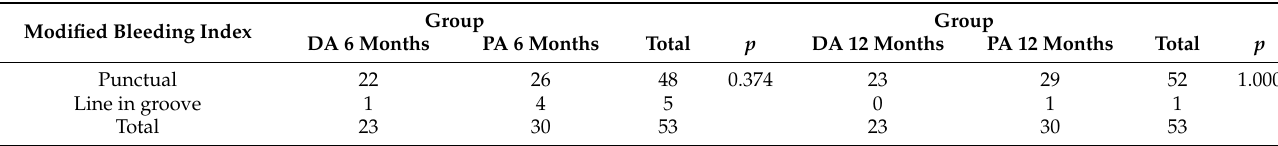
Table 4. Modified sulcus bleeding index, 6 and 12 months.